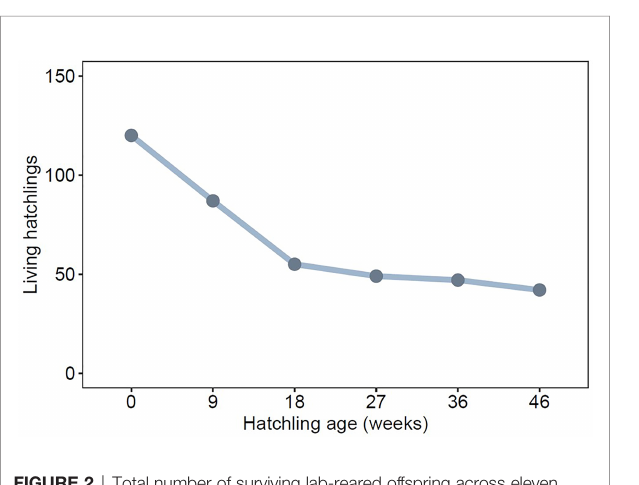
FIGURE 2 | Total number of surviving lab-reared offspring across eleven clutches at weekly age intervals. TABLE 1 | Logistic regression output for the probability of offspring survival to 323 ± 2 days of age, at which they have reached sexual maturity. Offspring survival b SE Intercept